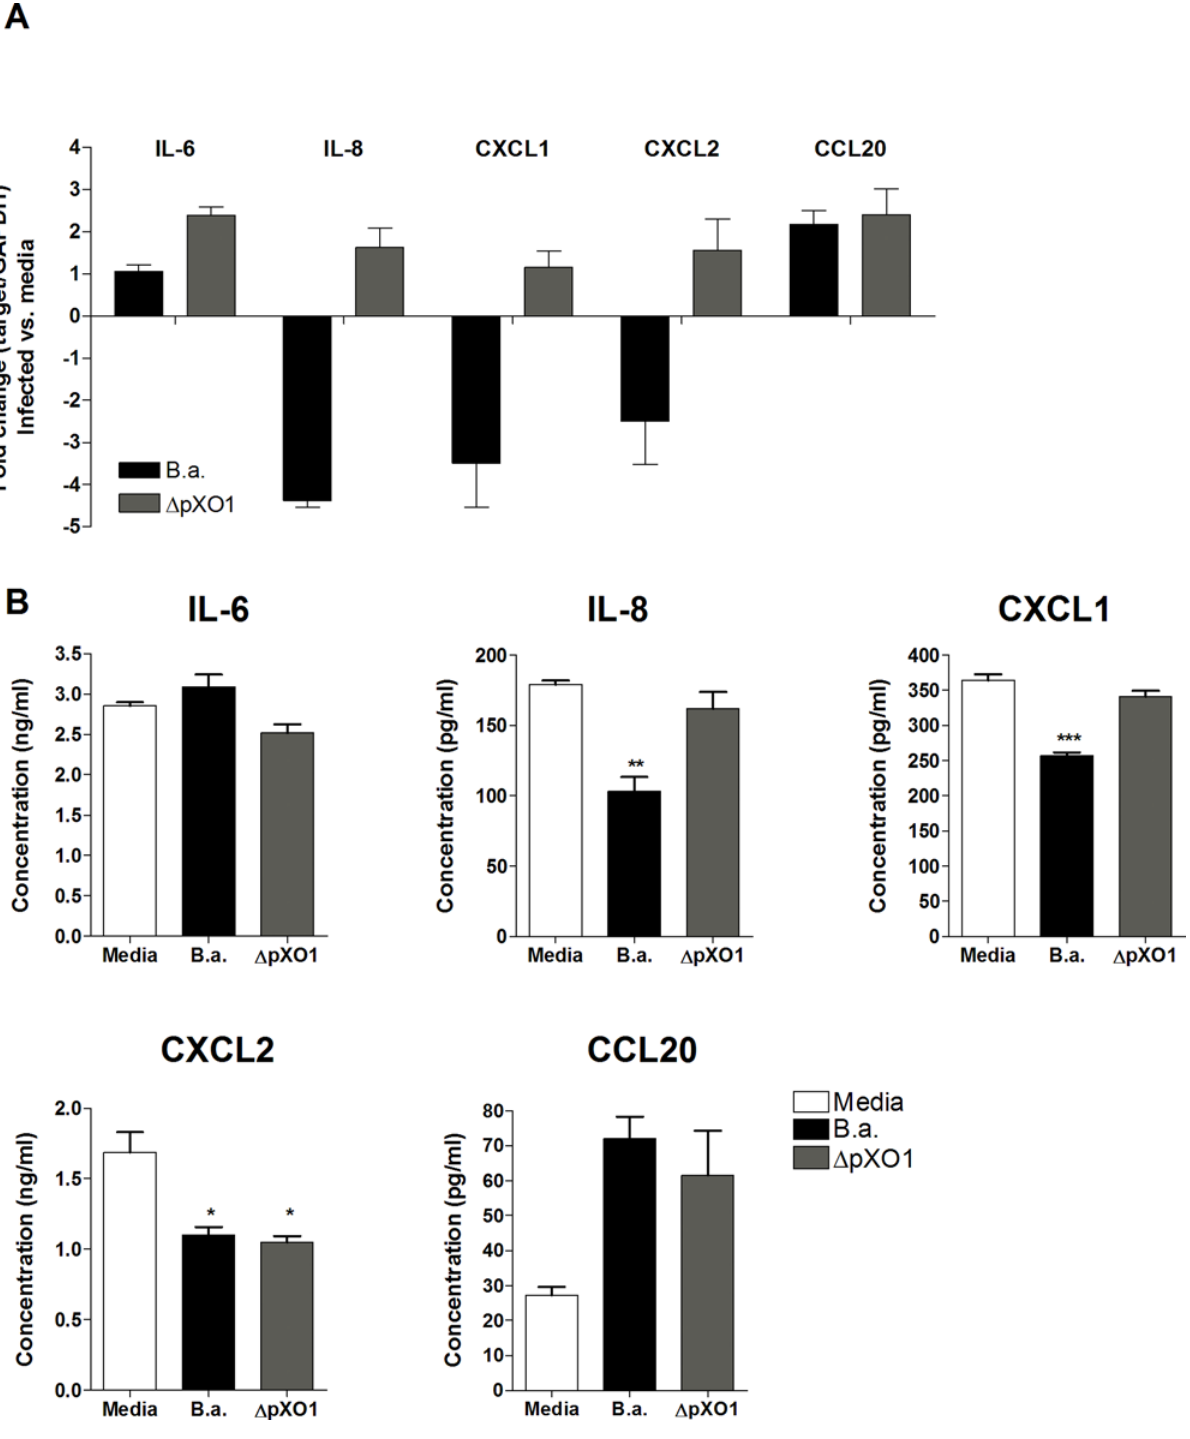
Figure 5. mRNA and protein expression of IL-6, IL-8, CXCL1, CXCL2 and CCL20 in hBMEC upon infection with B.anthracis Sterne (B.a.) or D pXO1 mutant bacteria. (A) mRNA expression levels of IL-6, IL-8, CXCL1, CXCL2 and CCL20 in hBMEC upon infection with B. anthracis Sterne (B.a.) or D pXO1 using quantitative RT-PCR. Fold change was determined as described in Material and Methods. Data represent mean and standard deviation of three independent experiments performed in triplicate. (B) Protein expression of IL-6, IL-8, CXCL1, CXCL2 and CCL20 in hBMEC supernatants 6 h post infection with B. anthracis Sterne (B.a.) or D pXO1 bacteria using ELISA. Experiments were performed three times in triplicate. Bars represent mean and standard deviation of one representative experiment. * p , 0.05, ** p , 0.005, *** p , 0.001.